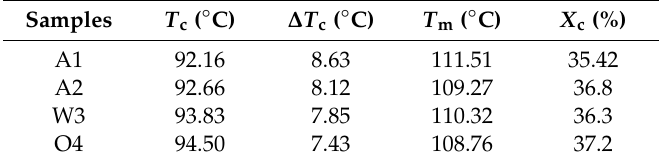
Figure 2. Heating and cooling curves of LDPE composites. Table 1. Parameters of isothermal crystallization and melting processes.